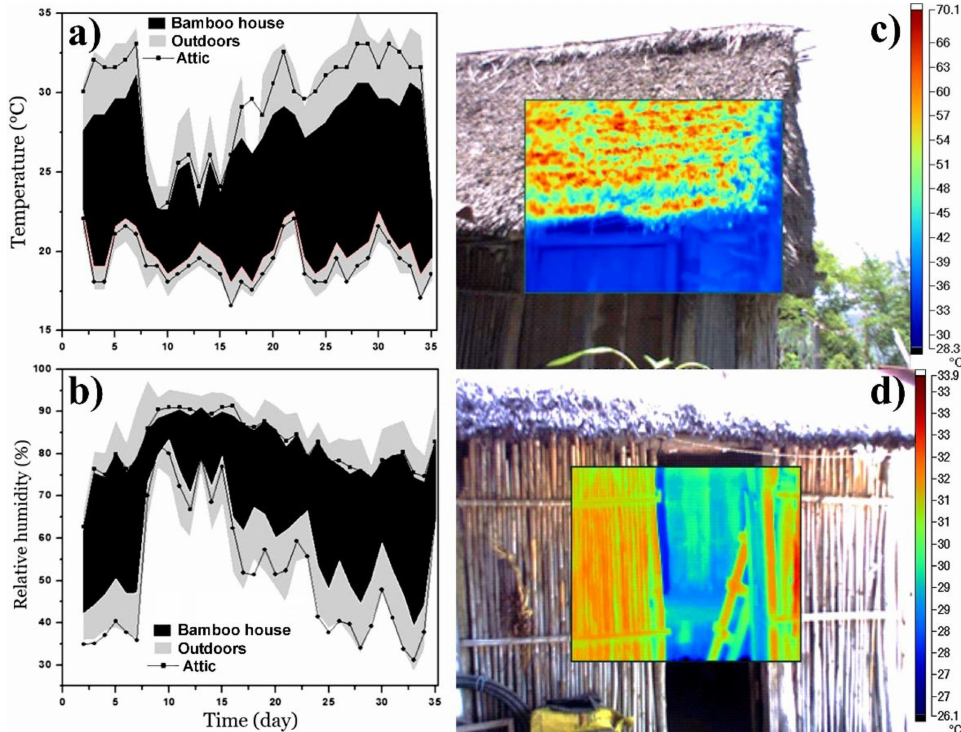
Figure 6. ( a ) Temperature and ( b ) relative humidity of the Bamboo ( Bambusa oldhamii ) house and outdoor environment. Lines are showing the values of the attic, locally named “ tapanco” . Thermo- graphic images of the bamboo house in the Sierra Gorda of Quer é taro, M é xico. ( c ) Roof view and ( d ) façade